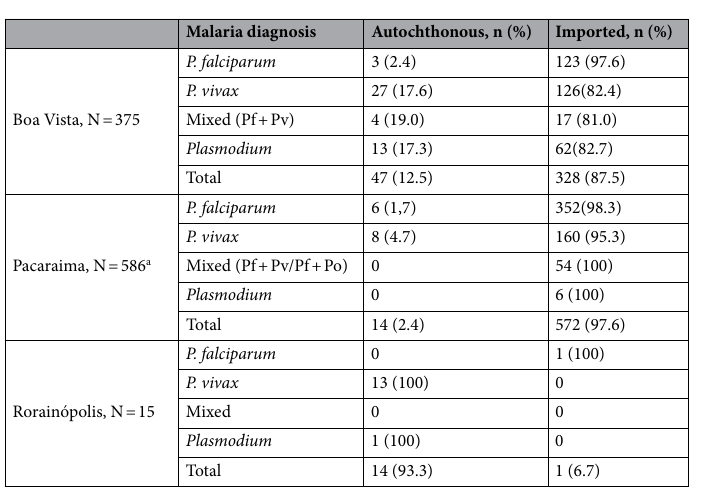
Table 2. Distribution of autochthonous and imported cases by Plasmodium species and study site. a Travel and country of origin of infection not provided for 7 samples (6 with P. falciparum and 1 Pf +